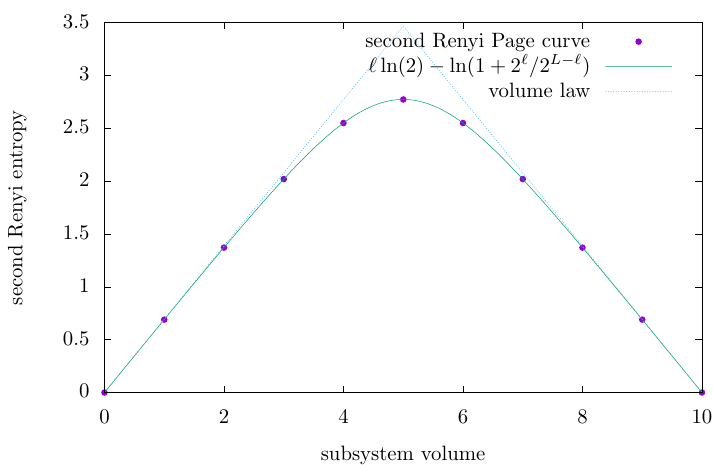
Figure 2 . The second Renyi Page curve for the random spin system. The curve is convex and symmetric at the